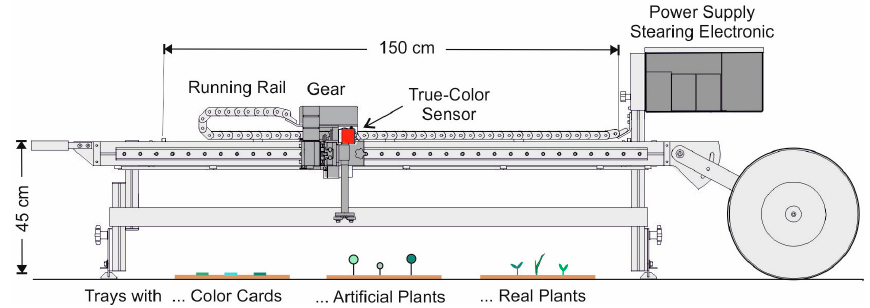
Figure 4. Stationary carrier for dynamic sensor tests.